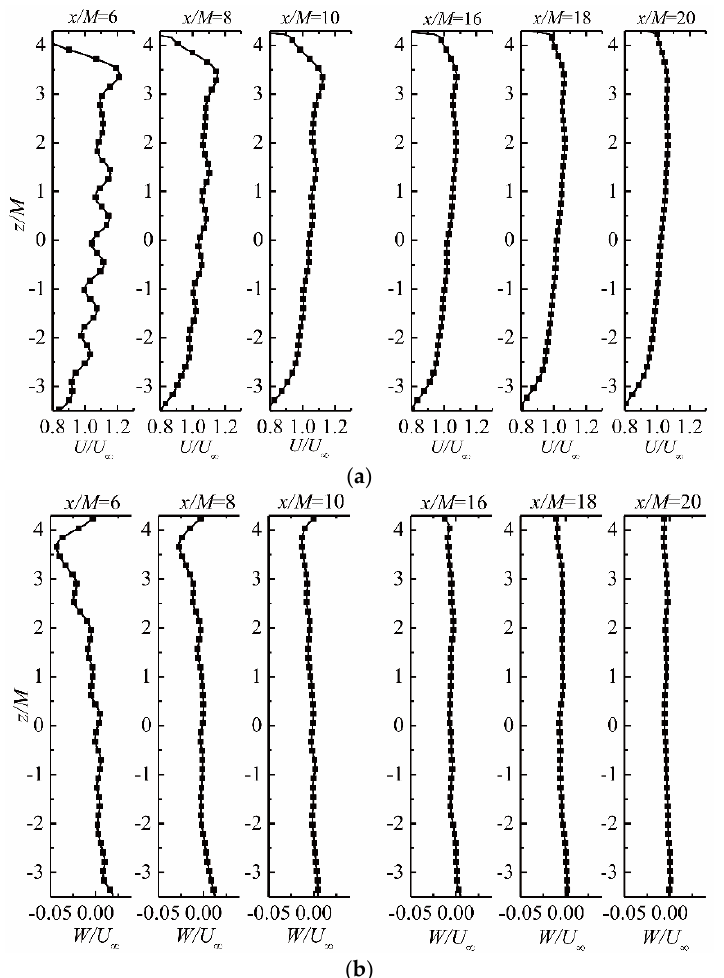
Figure 3. Vertical distribution of mean velocities at mid-span of channel ( a ) stream-wise components ( U / U ∞ ); ( b ) vertical components ( W / U ∞ ).